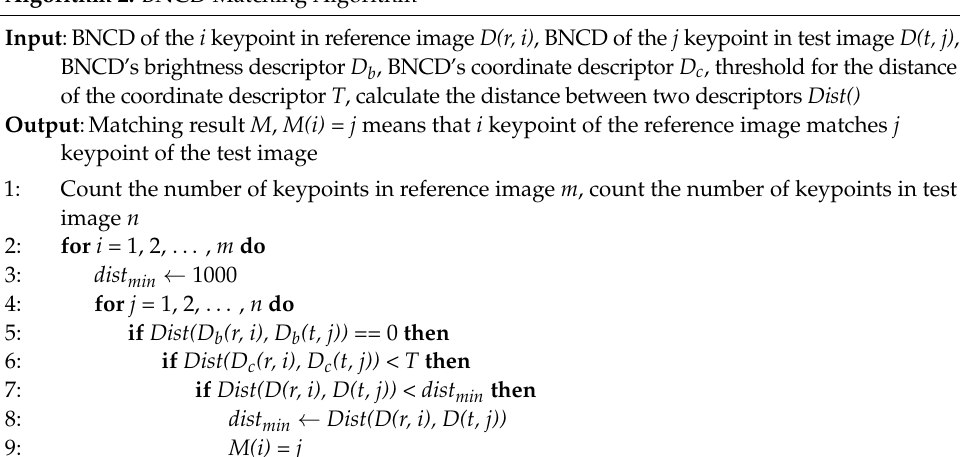
Algorithm 2: BNCD Matching